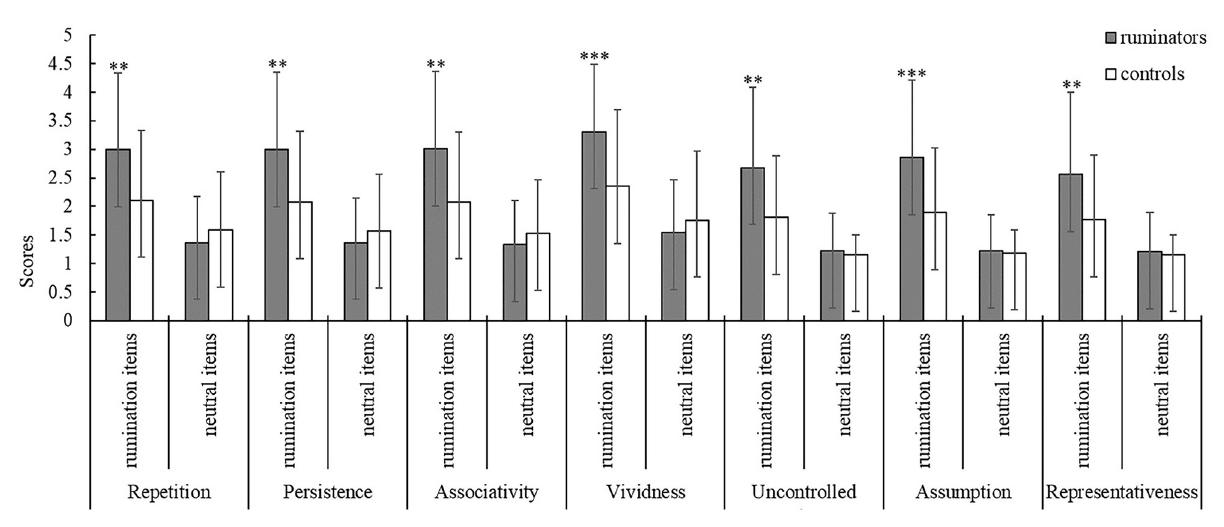
FIGURE1 Comparison of ruminator and control subject scores on the rumination and neutral items under the seven dimensions. ** p < 0.05, *** p < 0.001, error line represents the standard deviation.